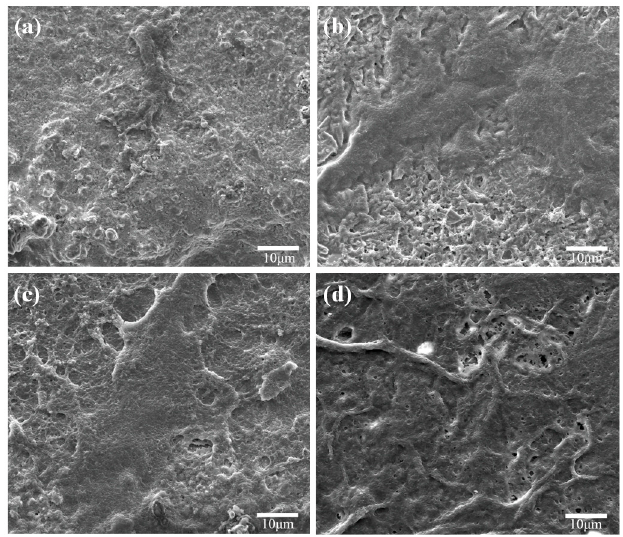
Figure 10. Morphologies of MG63 cells cultured on scaffolds without CaSiO 3 ( a , b ) and scaffolds with 20 wt % CaSiO 3 ( c , d ) for three days ( a , c ) and five days ( b , d ).